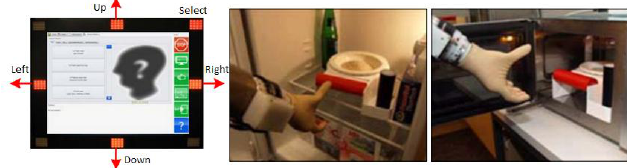
Fig. 7. A user selects the “prepare meal” in the FRIEND BCI system.